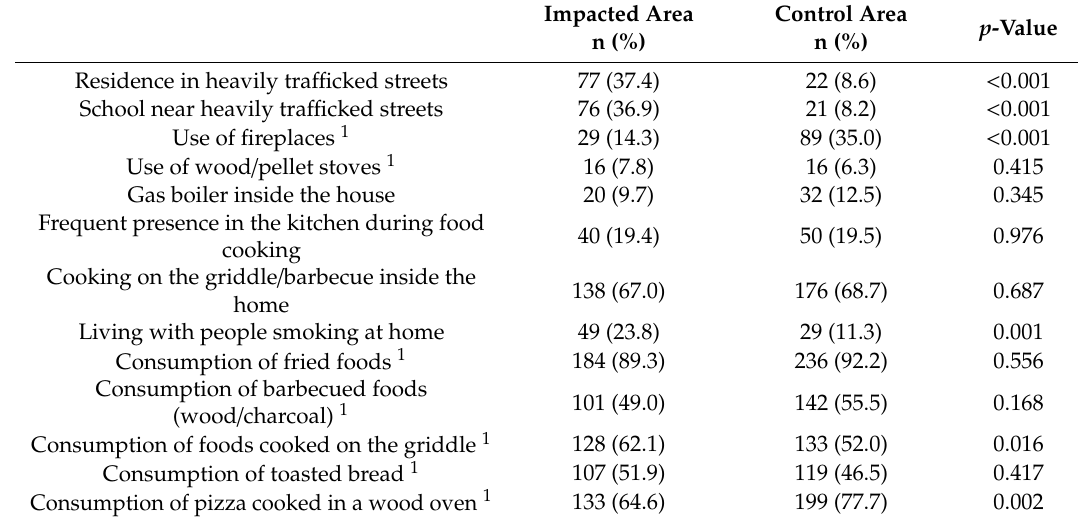
Table 4. Exposure factors related to children’s lifestyle and domestic environment.